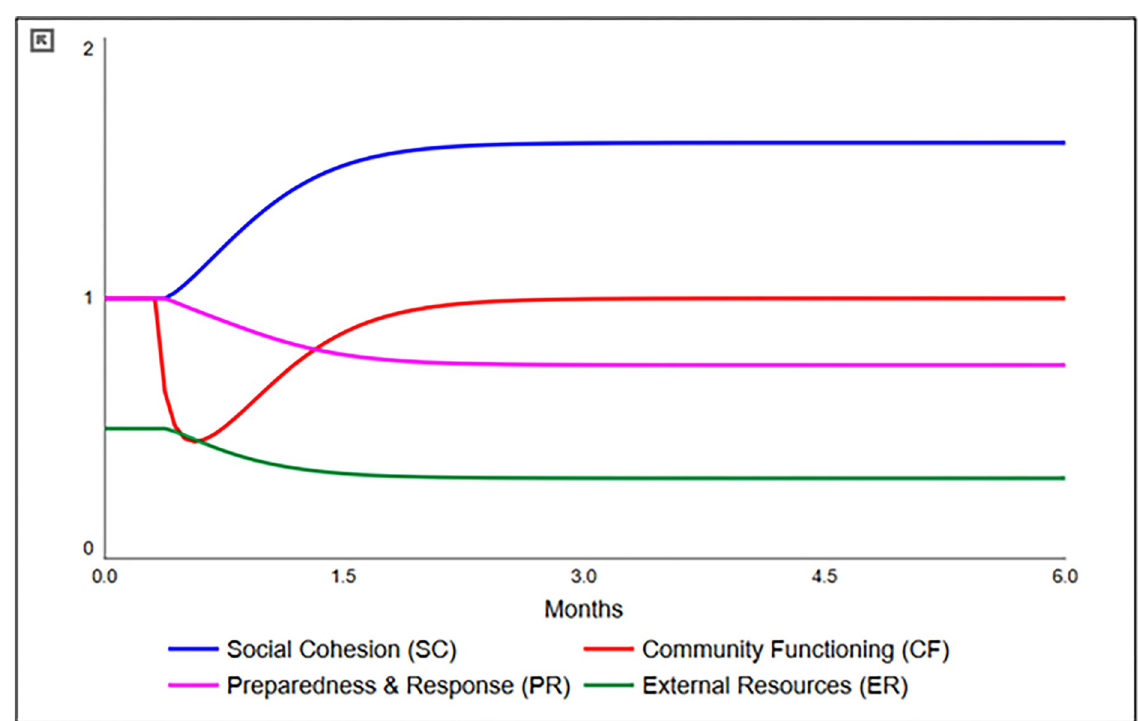
Fig 4. System dynamics model output, showing the depletion of the community functioning (CF) stock and replenishment from other stocks (SC, PR, ER).